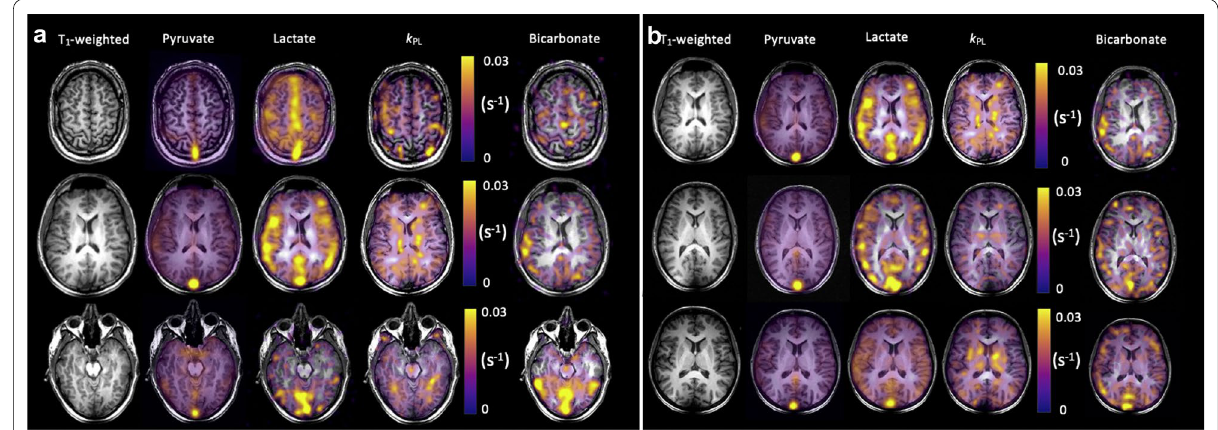
Fig. 3 Iterative Decomposition with Echo Asymmetry and Least squares estimation (IDEAL) spiral 13C imaging demonstrating metabolite